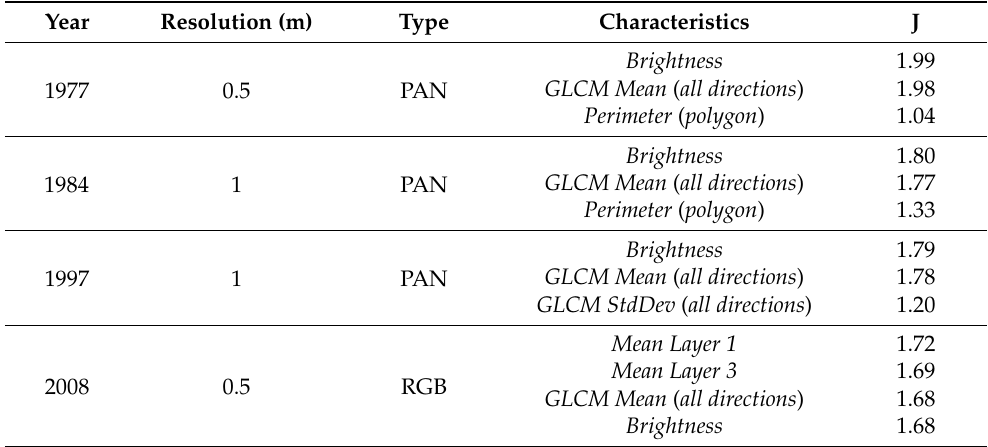
Table 5. Features used in the classification and the separability value J in each image. The separability value J indicates the characteristics of the classes that give the highest separability between them. A value of J close to 2 indicates a maximum separability of the classes, giving the best possible classification of the objects. PAN: panchromatic image; RGB: red-green-blue image. GLCM : grey-level co-occurrence